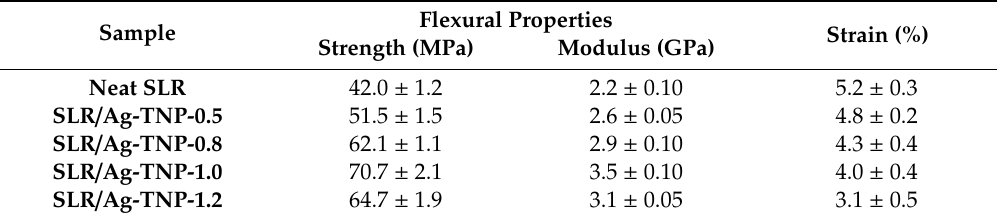
Table2. ResultsofflexuralstrengthandflexuralmodulusofSLR / Ag-TNPandneatSLRnanocomposites.